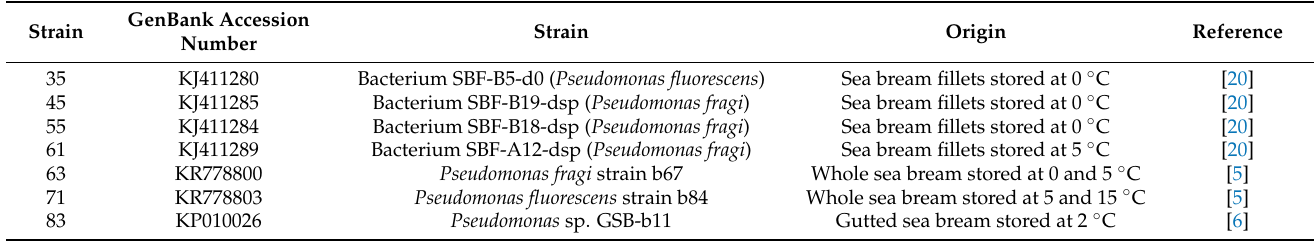
Table 1. The bacterial strains used to inoculate the fish juice agar model